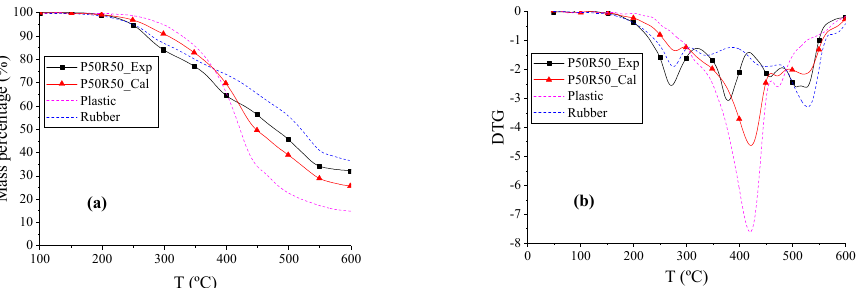
Figure 3. The TG and DTG thermograms of P, R, and P50R50. ( a ) TG thermograms reflects the change in mass percentage during pyrolysis process. ( b ) DTG thermograms refer to the derivative curves of TG thermograms.